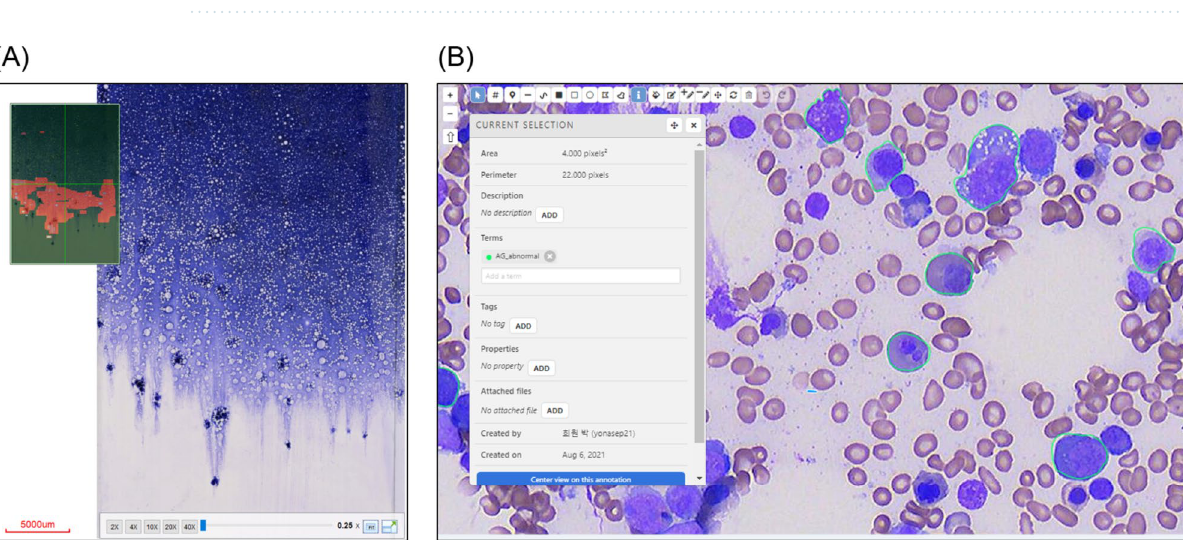
Figure 2. Dataset preparation and proposed framework.